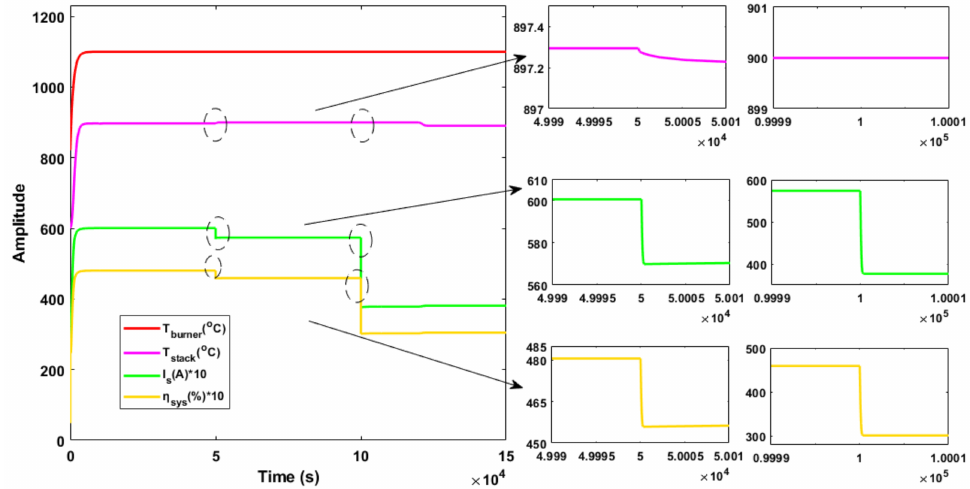
Figure 12. The performance parameter curve of system mode change caused by SOFC stack fault. Table 10. Temperature distribution of stack nodes due to SOFC stack performance